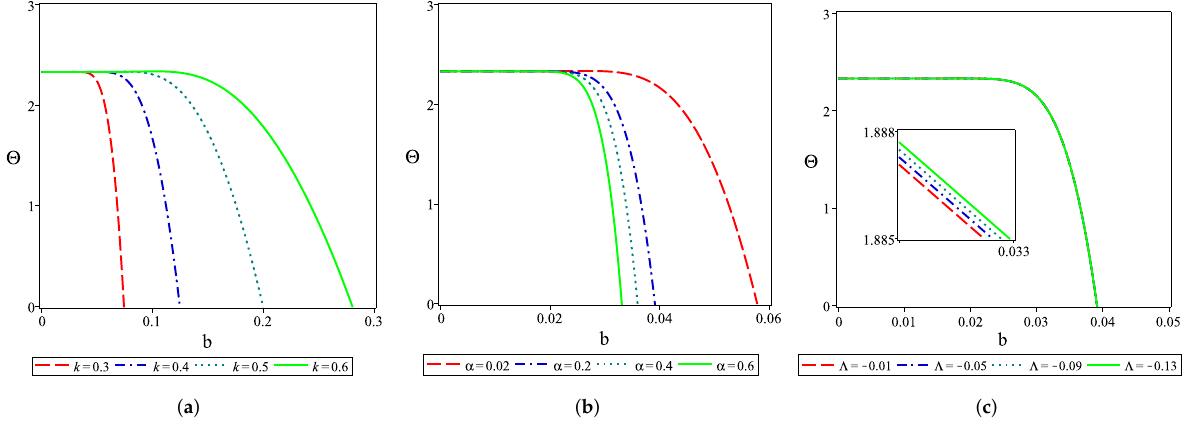
Figure 3. The behavior of Θ with respect to the impact parameter b for M = 1 and different values of k , α and Λ . One verifies from Figure 3a, that the k parameter increases the light deflection, and from Figure 3b that the GB parameter has an opposite effect on Θ . In Figure 3c, we verify that the cosmological constant exhibits a decreasing contribution on the light deflection. See the text for more details. ( a ) α = 0.2 and Λ = − 0.02; ( b ) k = 0.2 and Λ = − 0.02; ( c ) k = α =